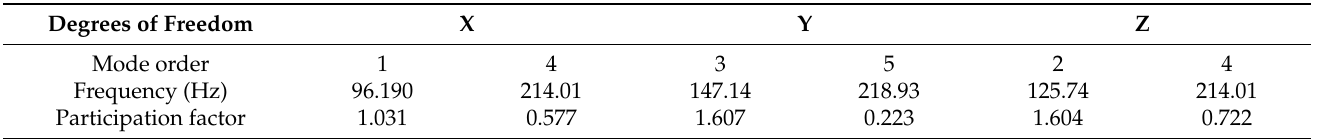
Table 4. Order, frequency and participation factors of the basic mode of the radar installation